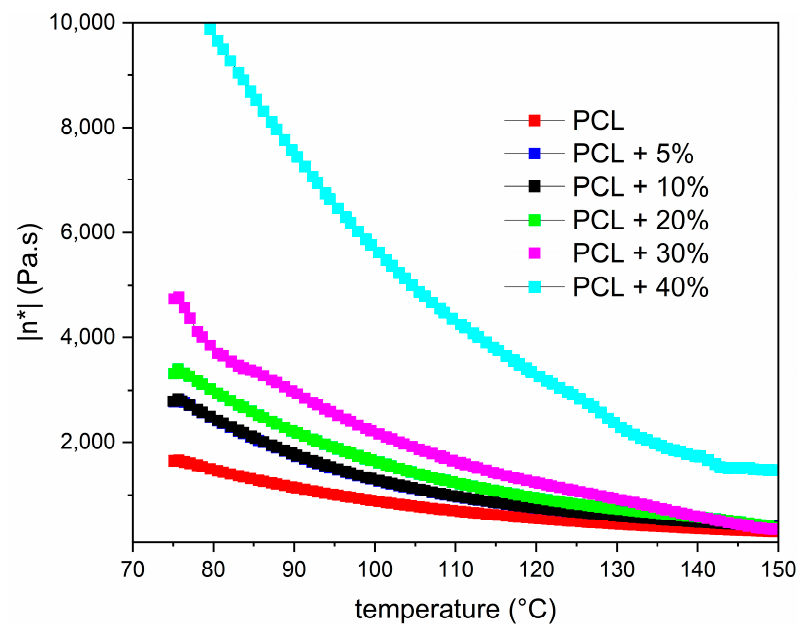
glass Figure 3. Temperature dependency of complex viscosity for PCL and its composites with hollow glass beads.